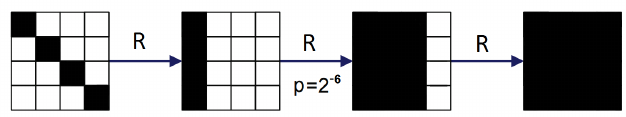
Figure 5: Truncated differential characteristic over 3-round AES. White box denotes a byte with a zero difference, while black box denotes a byte with a non-zero